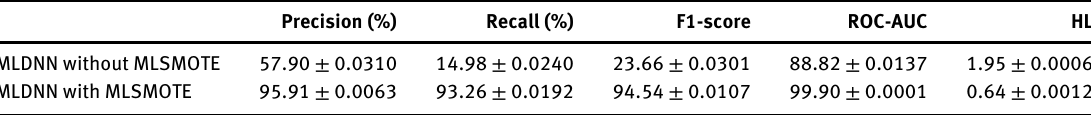
Table 3: Performance comparison of MLDNN with and without